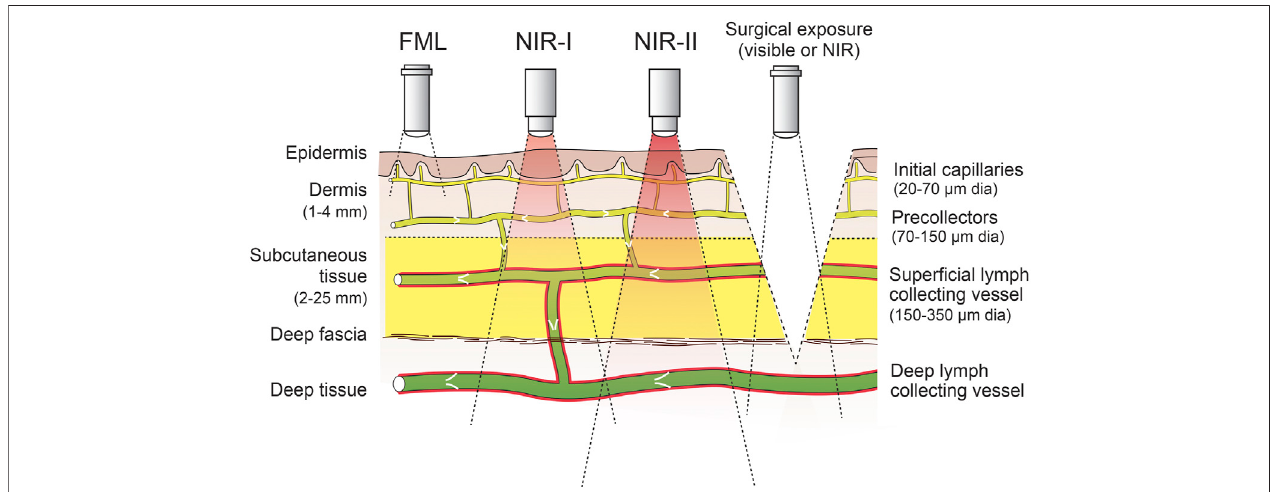
FIGURE1| Useof fl uorophoresthatemitatdifferentwavelengthsallowsvisualizationoflymphaticsatdifferentdepthsforskin-intactimaging.Alternatively,surgical exposurecanbeusedtovisualizedeeperlymphaticvessels.Intraluminalvalvesandsmoothmusclecellsareshowninwhiteandred,respectively.Measurementsonthe left indicate approximate depths in human skin tissue, and measurements on the right indicate approximate diameters of lymphatic vessels. Fluorescence microlymphography (FML) uses fl uorophores emitting at a visible wavelength (~400 – 700 nm). The tissue depth at which NIR imaging devices can detect NIR fl uorophores(NIR-I wavelength~700 – 1,000 nm; NIR-II wavelength ~1,000 – 1,700 nm) isdependent upon their brightness and the sensitivity ofthe device,but itcan be as much as 3 – 4 cm (Zhu and Sevick-Muraca, 2014).